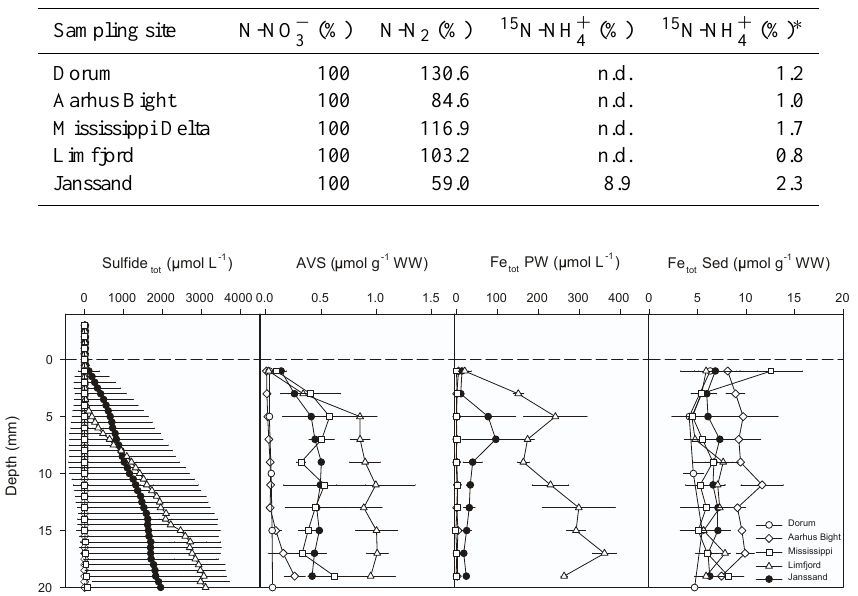
Table 3. Mass balance for dissimilatory nitrate reduction in intact sediment cores sampled at five coastal marine investigation sites. Fluxes of N-NO − were set to 100% and fluxes of N-N 2 (indicating DEN activity) and 15 N-NH + 3 relative shares of NO − fluxes. ∗ Estimated from depth-integrated rates of 15 NH + 3